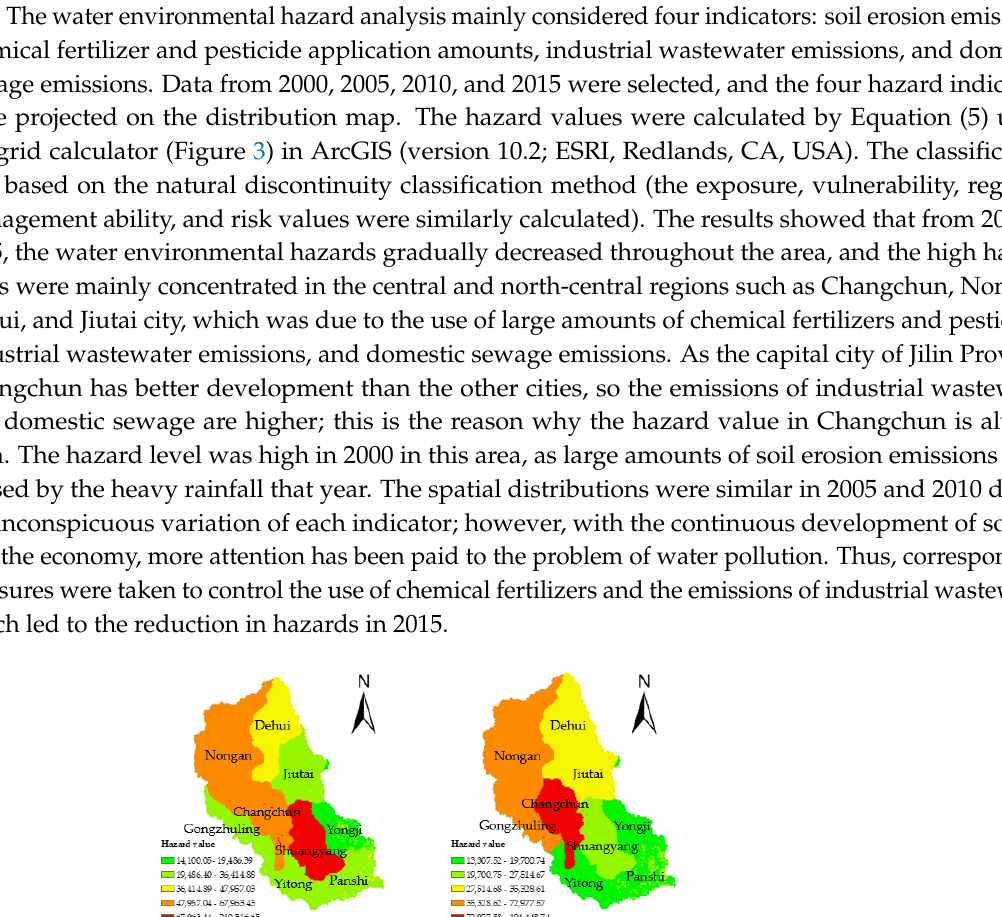
Table 3. Calculation results of the judgment matrix based on the PSO-AHP model.